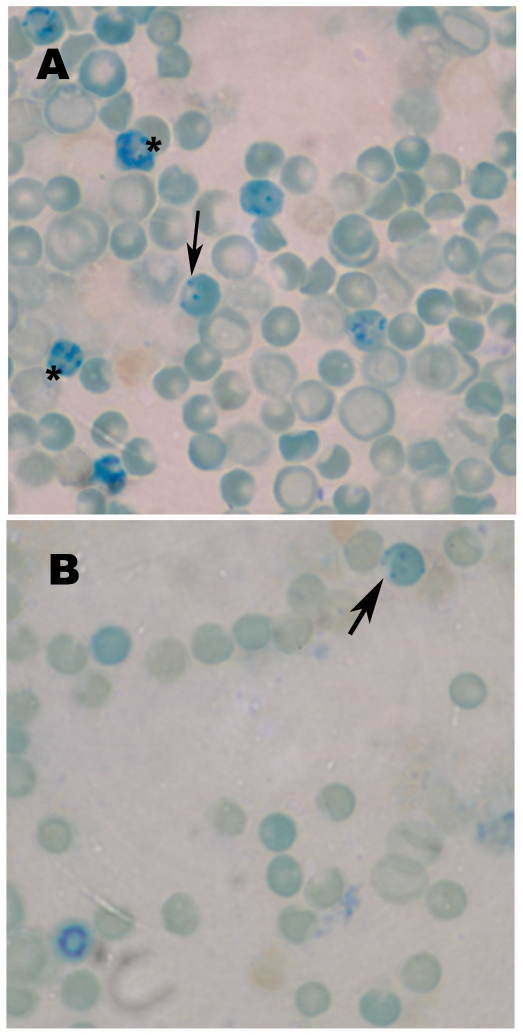
Morphology of erythrocytes from rats treated 24 h earlier with 2,6DNT.Photomicrographs at high magnification (100X objective with oil) of wedge preparations of blood vitally stained with new methylene blue are shown. Blood from rats treated with 199 (A) and 99 (B) mg/kg 2,6DNT are shown. Reticulocytes with blue stained mRNA are indicated by asterisks and arrows point to erythrocytes with indentations (bite cells).